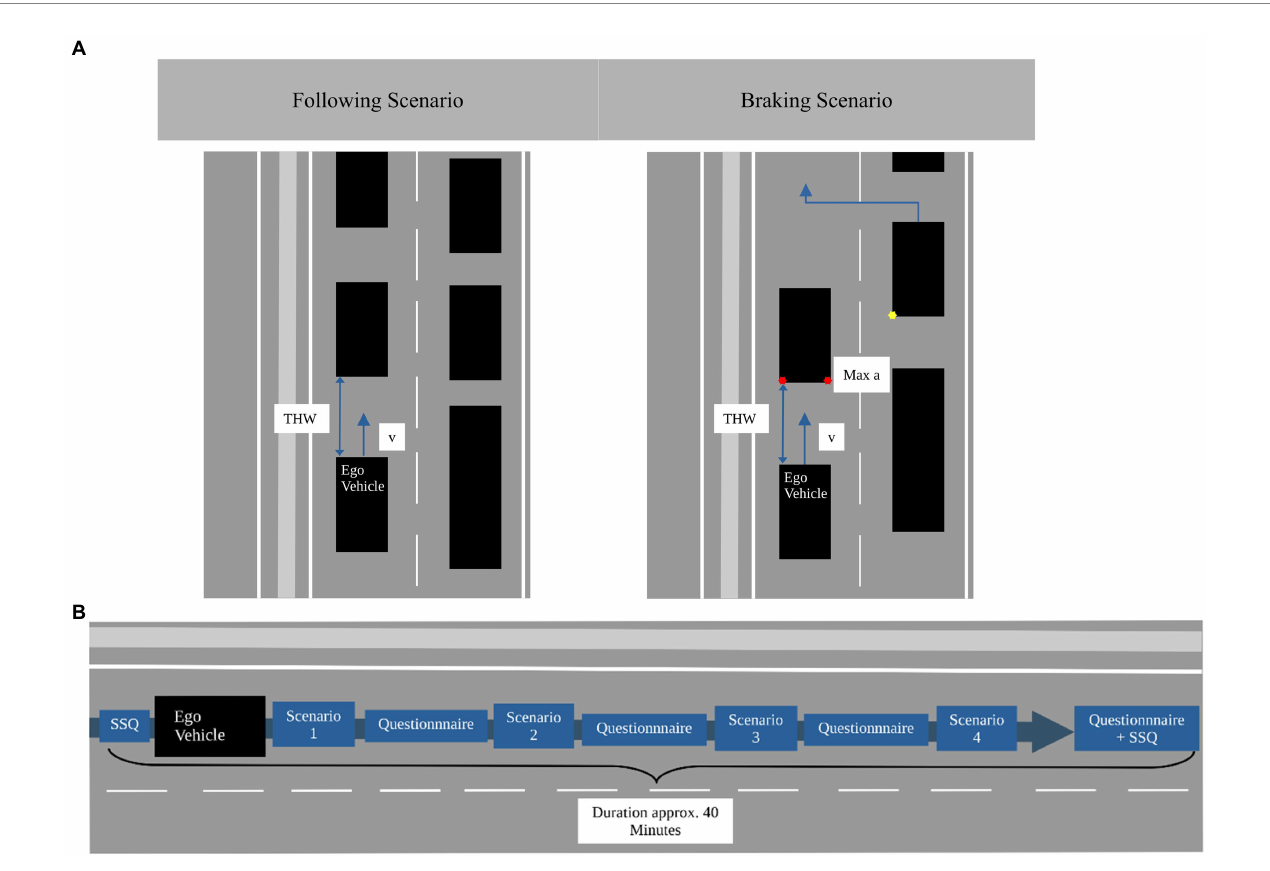
FIGURE 2 (A) Schematic flow of the following and braking scenario. (B) Procedure of a run in the feasibility